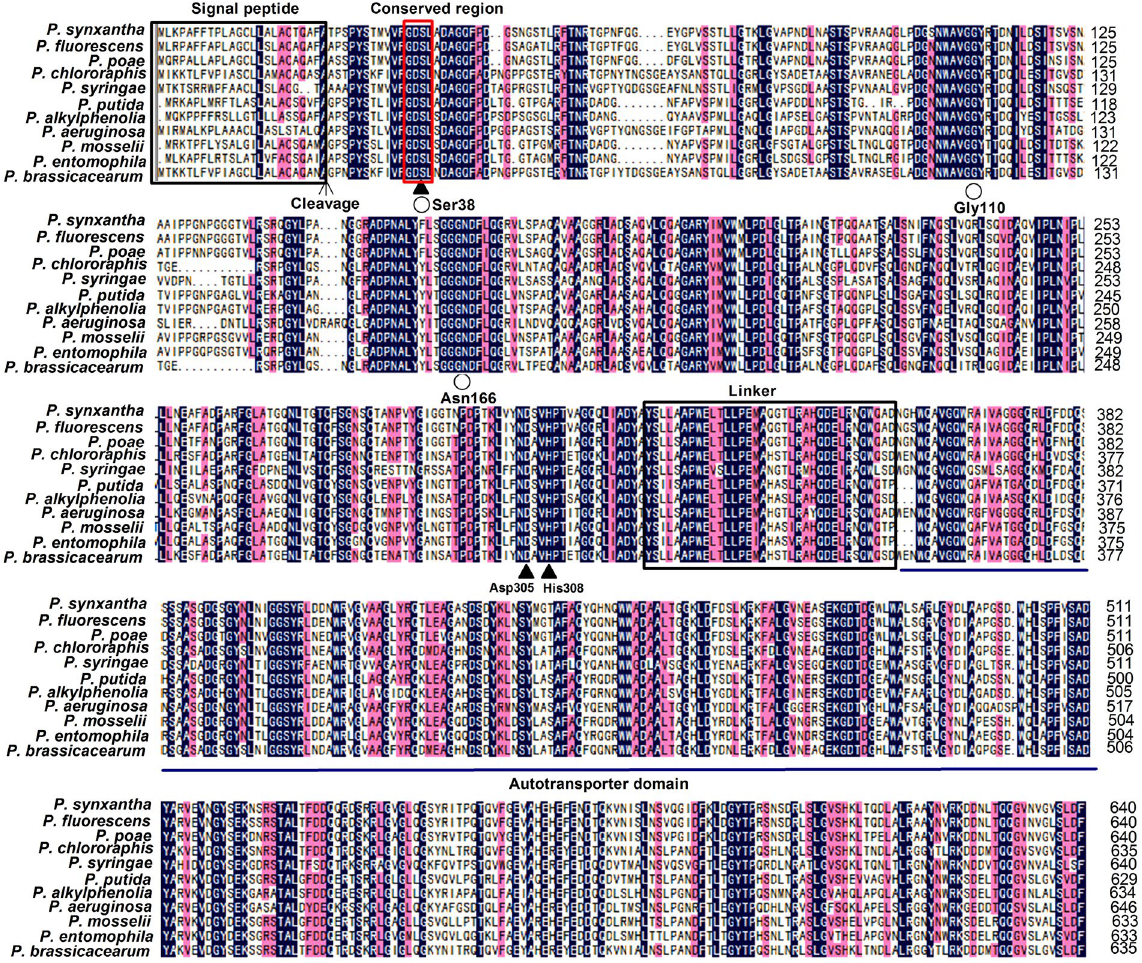
Figure 1. Conserved sequence alignment of EstPS1. The structures are denoted as follows: filled triangle, the catalytic site (Ser 38 , Asp 305 , and His 308 ); empty circle, the putative oxyanion hole (Ser 38 -Gly 110 -Asn 166 ). The reserved amino acid motif GDSL is boxed by the red line. The signal peptide and linker are also boxed. The consensus amino acid residues of the autotransporter domain are shown in underscore